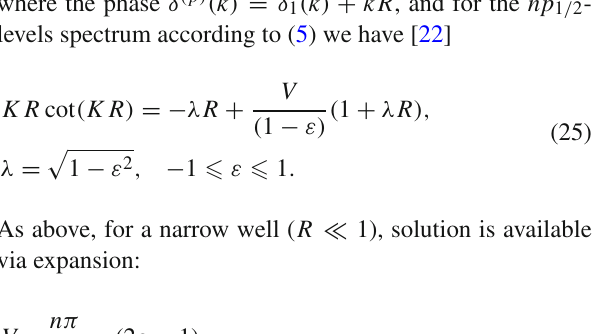
Fig. 5 Dependence of the position ε (dashed line) of the energy level of the electron quasistationary state on (cid:15)